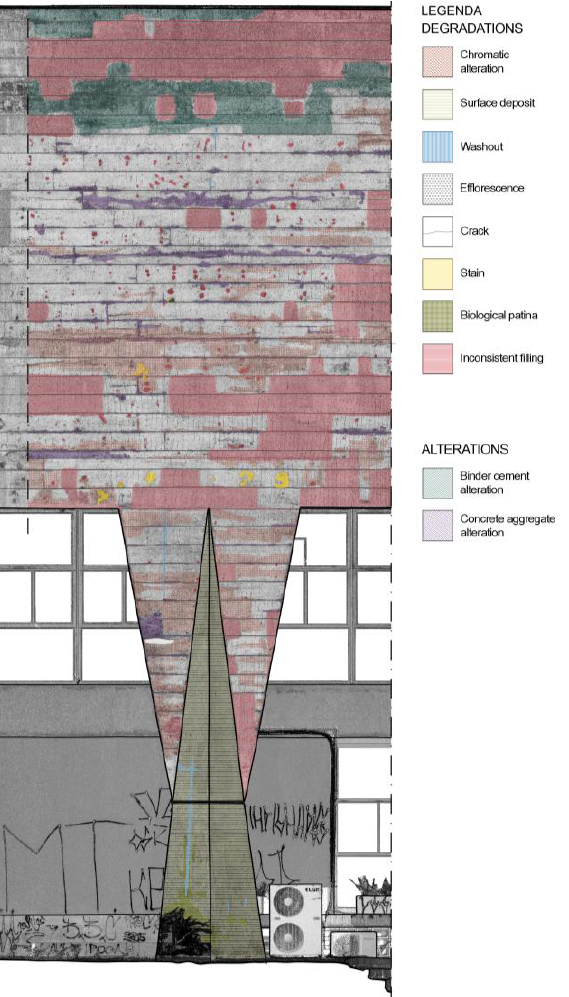
Figure 7. Detail of degradation